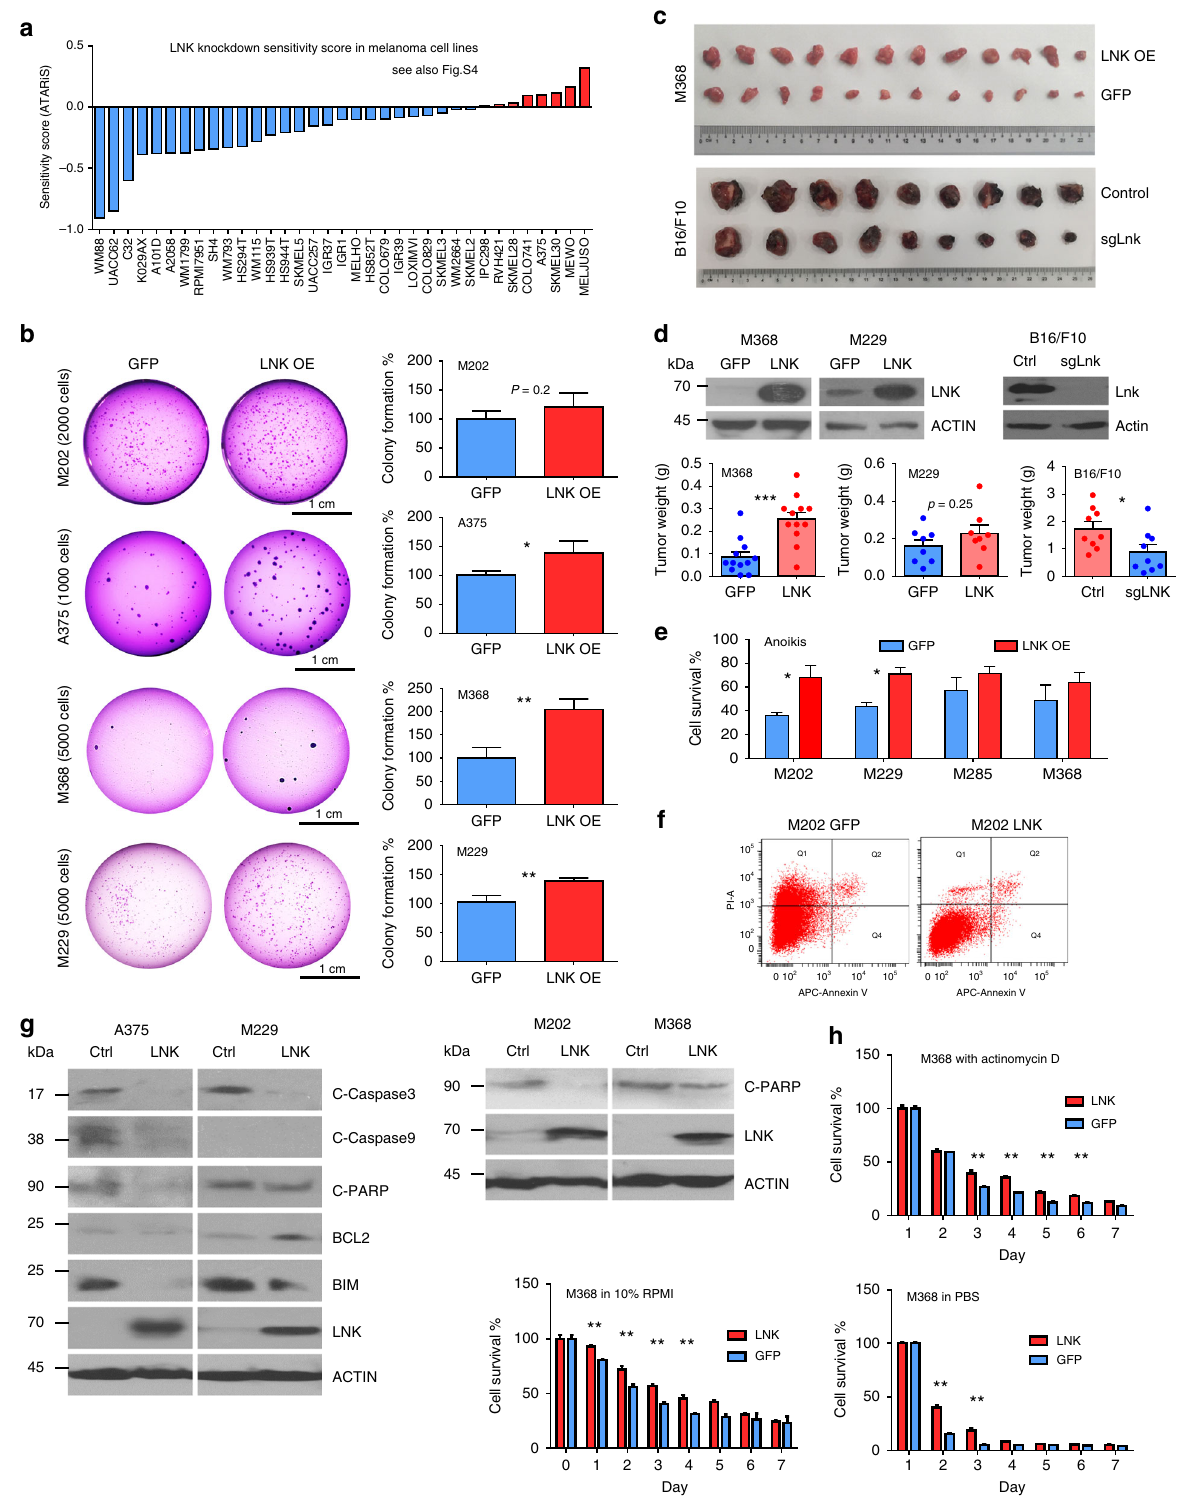
whether a direct interaction occur between LNK and STAT1 protein. Recombinant GST fusion protein of LNK (PH or SH2 domain) and STAT1 were generated and puri fi ed using E.coli strain TXK1 (Stratagene). The recombinant proteins were incubated with the cell lysate of HEK293T cells transfected with Flag tag STAT1 expressing constructs (GST-LNK pull down experiment) or cell lysis of A375 expressing V5-LNK (GST-